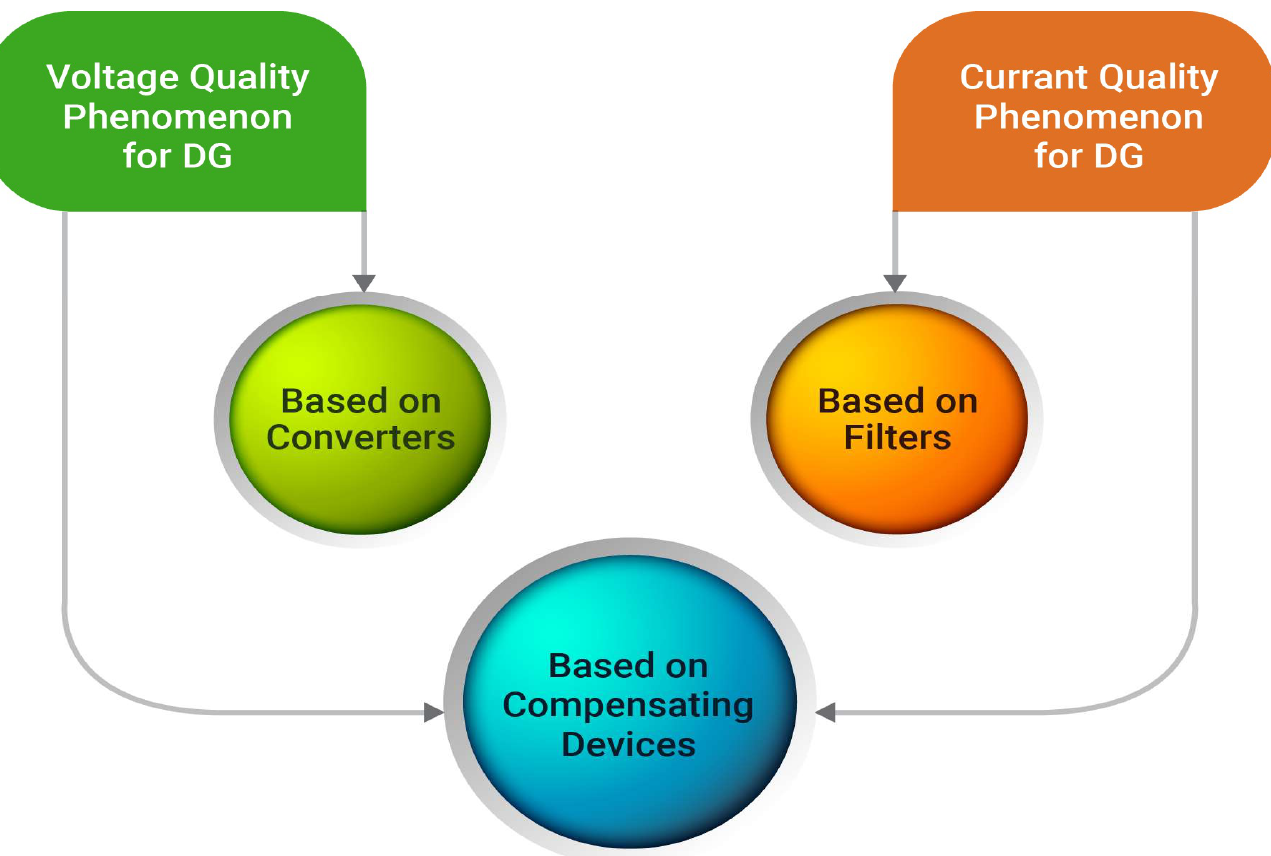
Figure 4. Quality perspective analysis in SG based on power electronic devices.